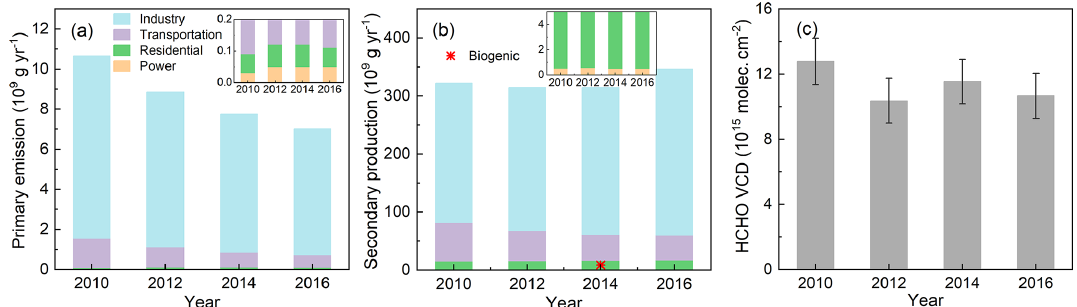
Figure 4. Primary and estimated secondary production of HCHO from anthropogenic NMVOCs. The biogenic contribution of HCHO in 2014 was marked as a red cross in (b)